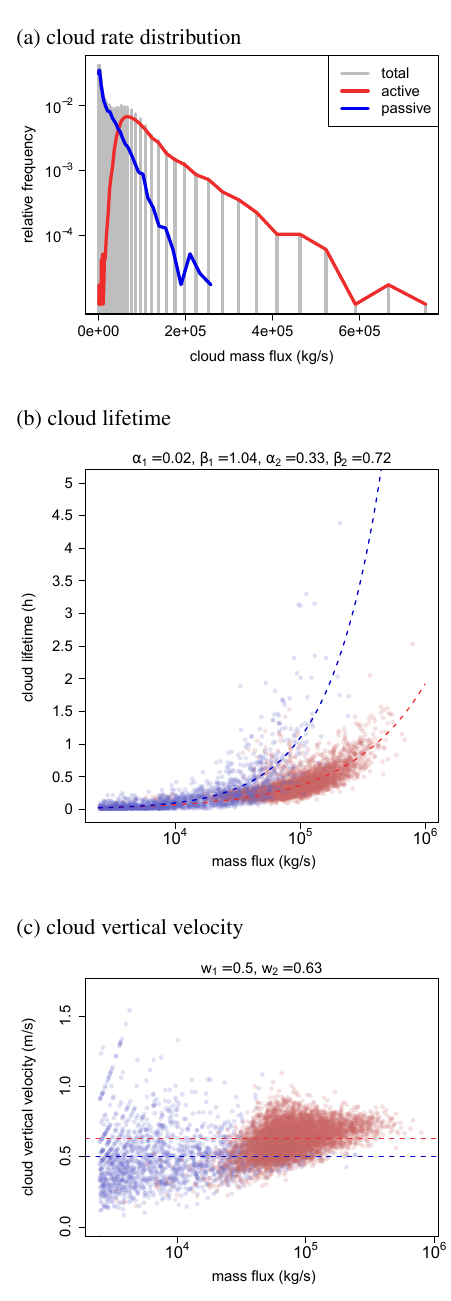
Figure 3. (a) Cloud rate density distribution of cloud-base mass flux with the split into active and passive distribution modes. (b) Scatter plot of the cloud lifetime and average cloud mass flux and (c) cloud lifetime and average in-cloud vertical velocity. Active clouds are shown as red points, while the passive clouds are in blue. The non- linear least square fit of the relation τ i = α i m β i , i = 1 , 2 is plotted for both cloud groups, with parameters α i and β i corresponding to the passive (1) and active (2) cloud groups. Vertical velocity w i , i = 1 , 2 is averaged over all clouds in each group and plotted as a horizontal